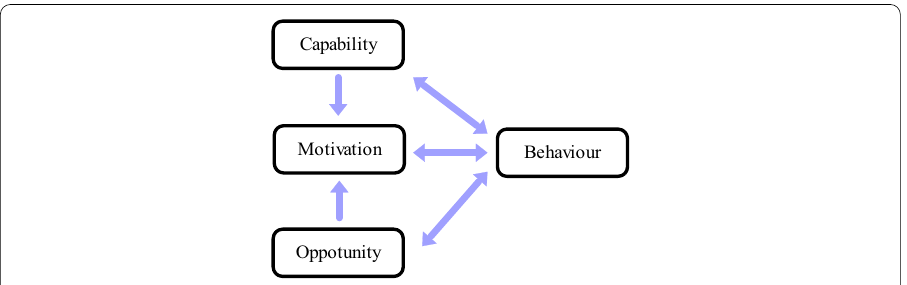
Fig. 1 The COM-B system—a framework for understanding behavior